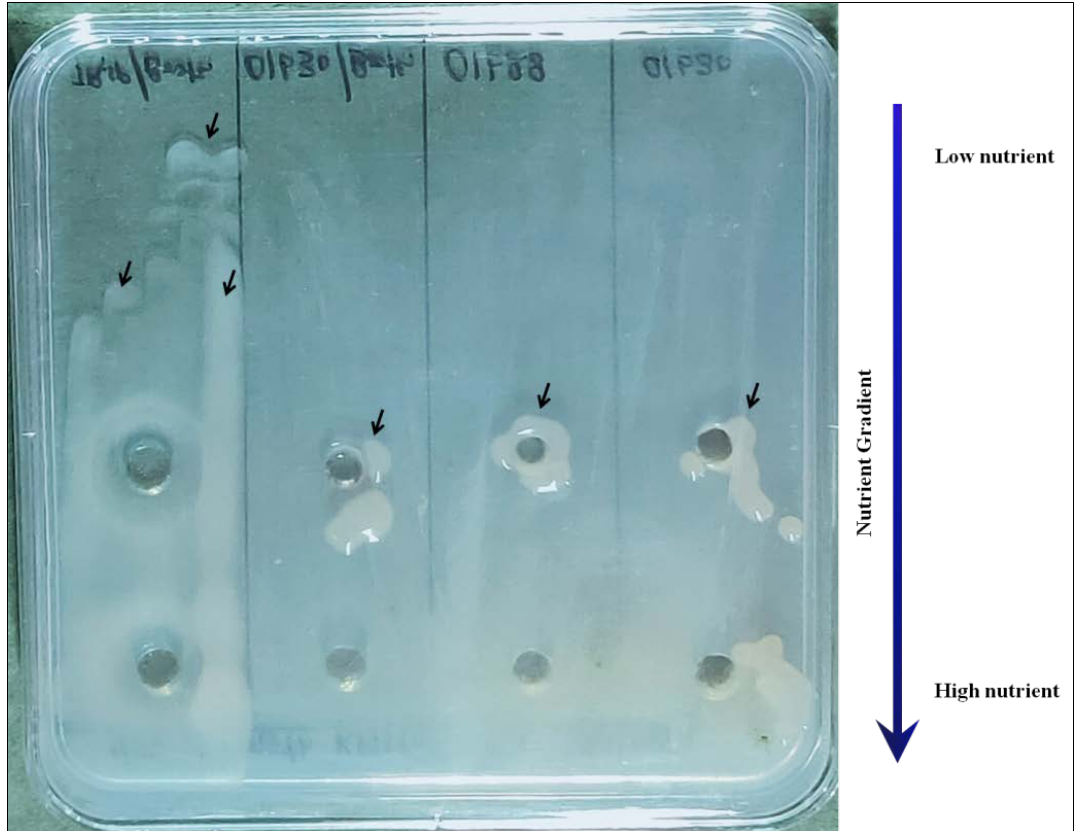
Figure 6. Induction of fluidal colony in 1/50 strength KMTTC media with Indian gooseberry extract in three days incubation; black arrow indicating virulent type colonies; left-to-right sequence = NAIMCC-B-01630 (fluidal), NAIMCC-B-01630 (non-fluidal), TB-01838, and NAIMCC-B-01630 (butyrous).